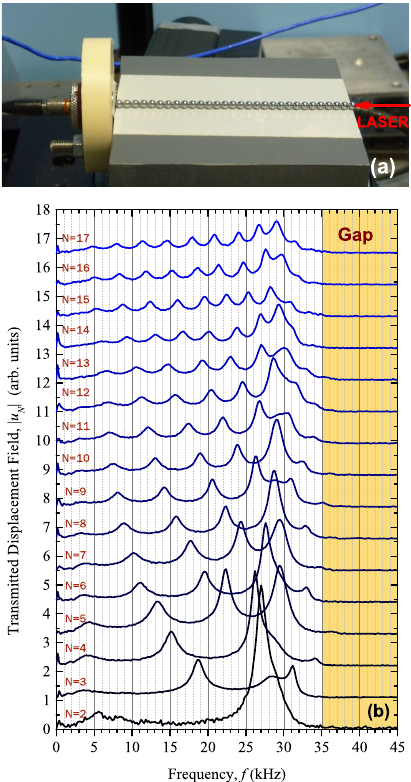
Figure 7. ( a ) chain of N metallic spheres of diameter d = 5 mm, excited by a longitudinal transducer ( left ) with the transmitted signal recorded at the end of the chain through LDV ( right ); ( b ) the modulus of the transmitted displacement field measured at the end of the chain, | u N ( f ) | , as a function of frequency f , for various chain lengths, L = Nd . The different spectra are displaced vertically to improve